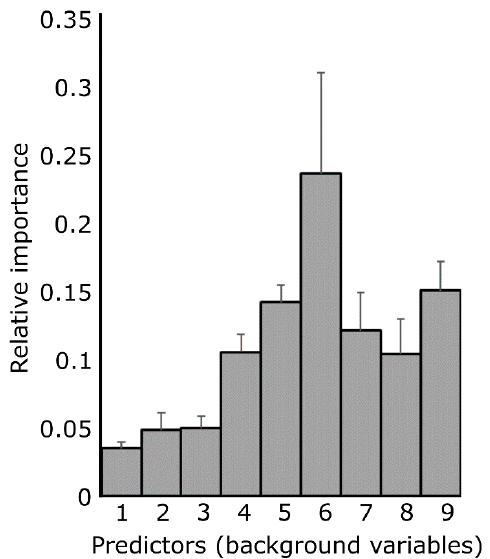
Figure A2. Relative importance of background variables in predicting between-participant similarities in the free association experiment. Relative importance values are means over 10 cross-validation folds, and error bars describe the standard error of the relative importance values over 10 cross-validation folds. 1 = Nationality (Finnish or Russian), 2 = Number of Russian parents, 3 = The level of Russian language, 4 = How often do I visit Russia, 5 = How Finnish do I feel myself, 6 = How Russian do I feel myself, 7 = How positively/negatively do I see Finns, 8 = How positively/negatively do I see Russians, 9 = IAT score. Interestingly, for the IAT scores, the question on how Russian the participants felt themselves, and the question how Finnish the participants felt themselves best explained the similarities and differences in the word listings, and for example, level of command of Russian language had a negligible effect.